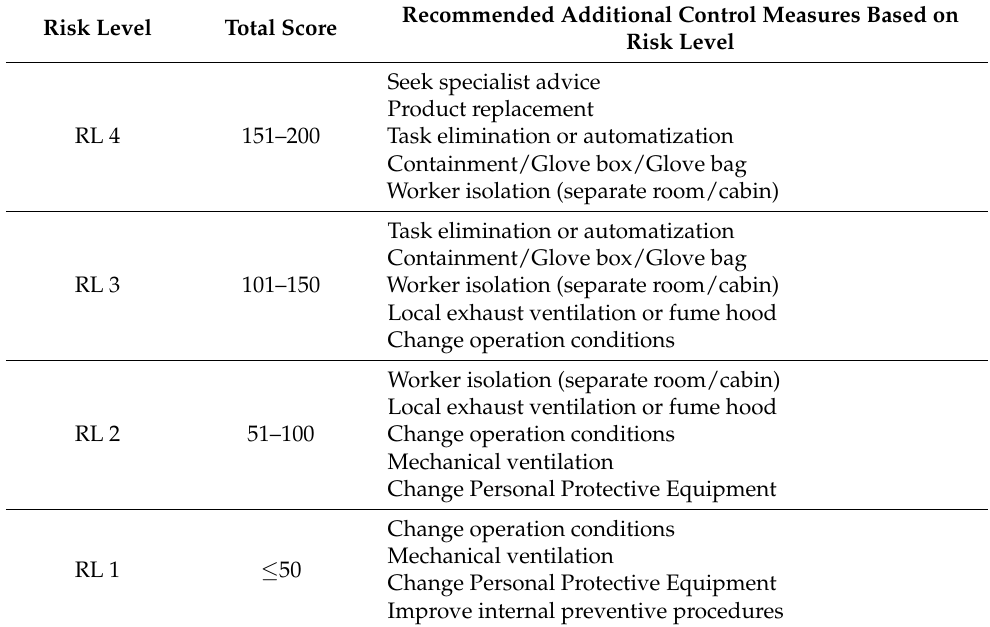
Table 9. Recommended additional control measures based on risk level.